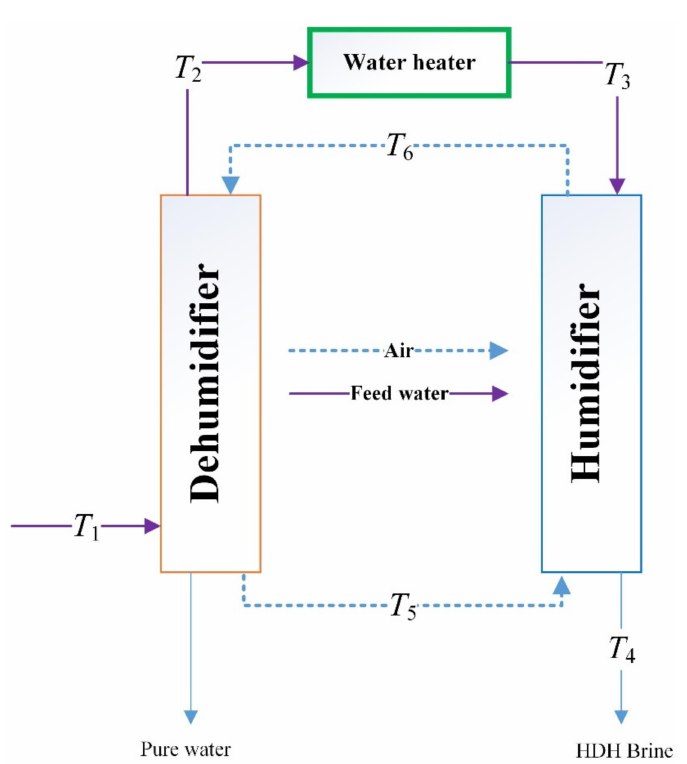
Figure 3. HDH desalination